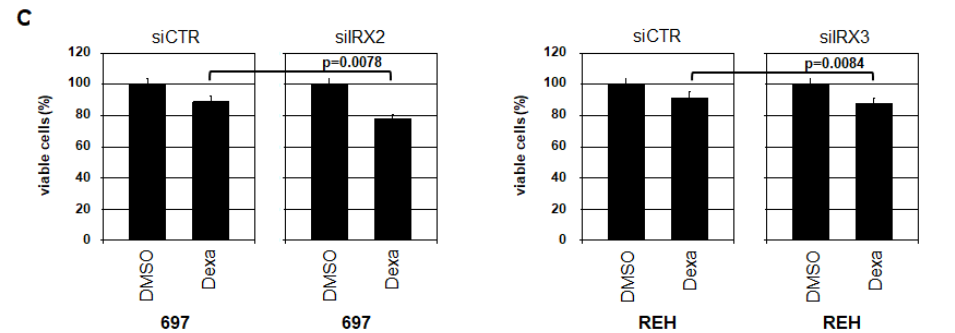
Figure 7. Oncogenic activities of IRX2 and IRX3 in BCP-ALL. ( A ) Live-cell imaging analysis of 697 cells treated for siRNA-mediated knockdown of IRX2. ( B ) Live-cell imaging analysis of REH cells treated for siRNA-mediated knockdown of IRX3. Standard deviations are shown as bars. Indicated p -values refer to terminal time points of treated versus control cells. ( C ) MTT assay analysis of 697 (left) and REH (right) treated for IRX knockdown and with 1 µM dexamethasone (Dexa) for 24 h, showing the percentage of viable cells. Standard deviations and p -values are indicated (t-test).